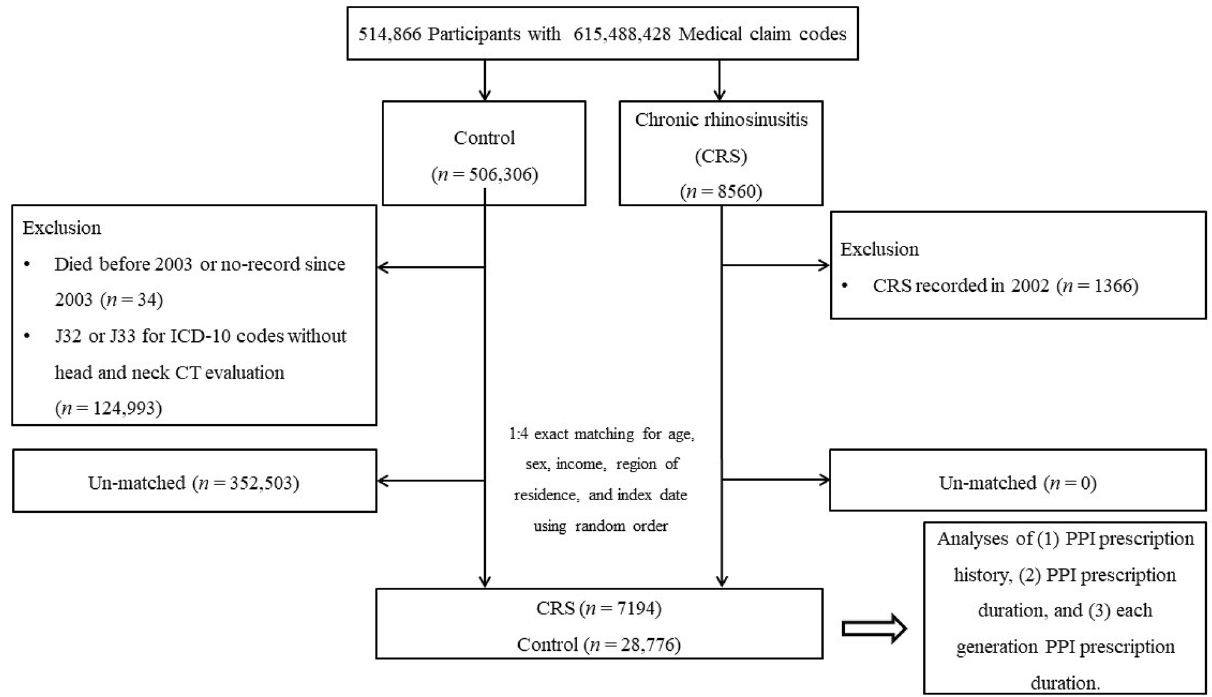
Figure 1. Schematic illustration of the participant selection process that was used in the present study. Of a total of 514,866 participants, 7194 chronic rhinosinusitis (CRS) participants were matched with 28,776 control participants with respect to age, group, sex, income, residence region of, and past medical